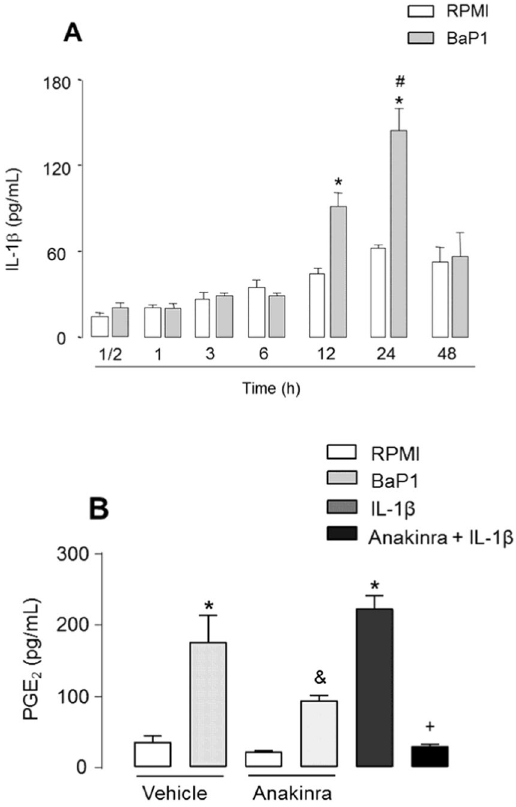
Figure 8. BaP1 induces production of IL-1 β , which contributes to PGE 2 production. ( A ) Time-course of BaP1- induced IL-1 β release. FLS monolayers were incubated with BaP1 (12.5 µ g/mL) or RPMI (control) for 30 min, 1, 3, 6, 12 and 24 h. ( B ) Isolated FLSs were pretreated with Anakinra (50 μ M) or vehicle and stimulated by BaP1 (12.5 mg/mL) or RPMI (control) or IL-1 β for 12 hours. Supernatants were collected, and IL-1 β and PGE 2 were quantified by ELISA. Results are expressed as mean ± SEM of 4 samples. * p < 0.05 relative to control. # p < 0.05 relative to BaP1 (12 h); & p < 0.05 relative to BaP1; + p < 0.05 relative to IL-1 β (two-way ANOVA, Bonferroni post test in A and one-way ANOVA, Bonferroni post test in